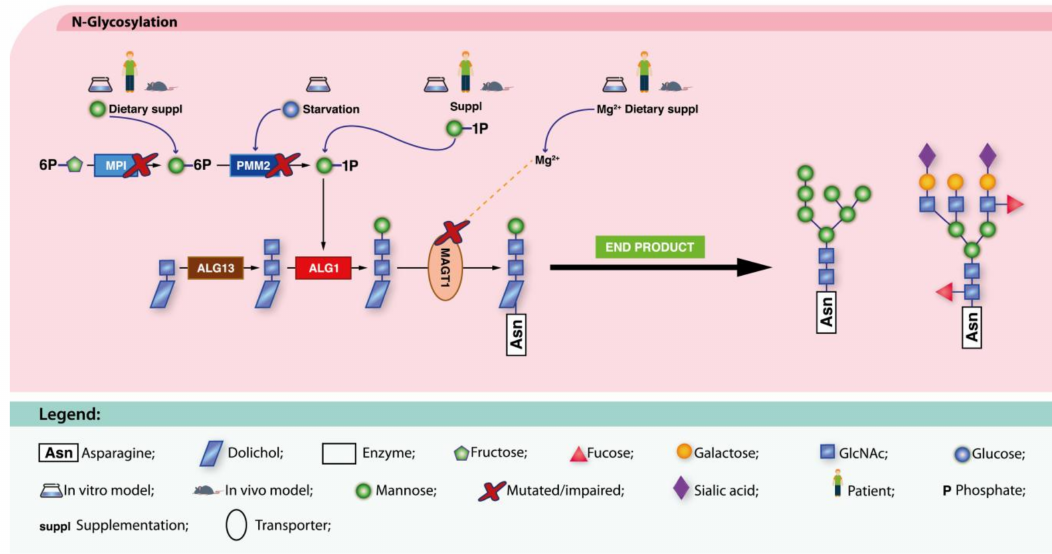
Figure 1. Dietary supplementation approaches under investigation for ALG1-CDG, MPI-CDG, PMM2-CDG and MAGT1-CDG. For MPI-CDG and PMM-CDG, exogenous Man or Man-1-P respectively, is administered (blue arrows). For PMM2-CDG, glucose starvation (blue arrow) was also studied. For ALG1-CDG, Man-1-P supplementation (black arrow) might also represent a promising approach. Mg 2+ supplementation (blue arrow) is used to correct MAGT1 transporter defect (dotted yellow line). These therapeutic approaches aim to recover the metabolic pathways (black arrows) and ultimately, the normal glycosylation profile (bold black